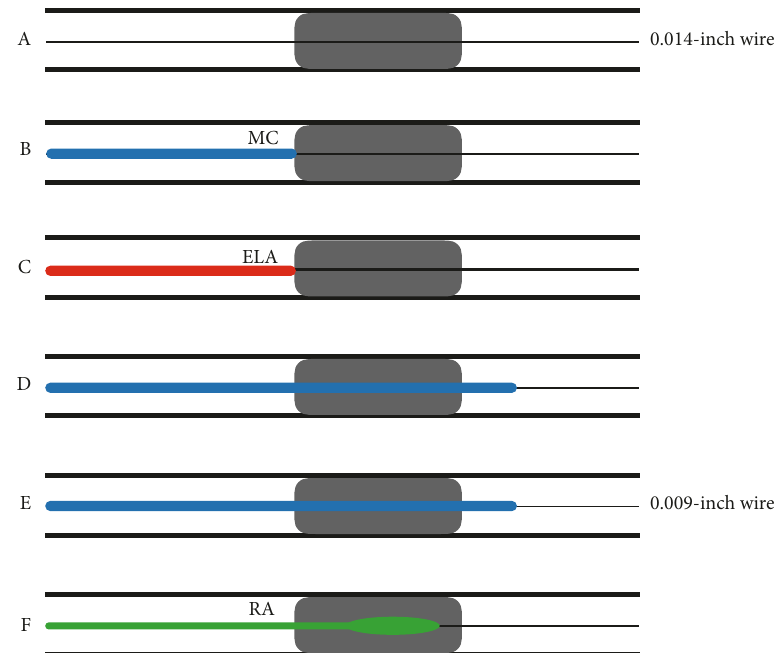
Figure 6: The schema of the “RASER” technique. A: conventional 0.014-inch wire crosses the severely calcified lesion. B: microcatheteroften cannot pass the lesion. C: excimer laser catheter ablates and modifies the entry of the lesion. D: this modification enables a microcatheter to pass the lesion. E: exchanging to a 0.009-inch Rota-wire from a 0.014-inch conventional wire. F: high-speed rotational atherectomy is performed.